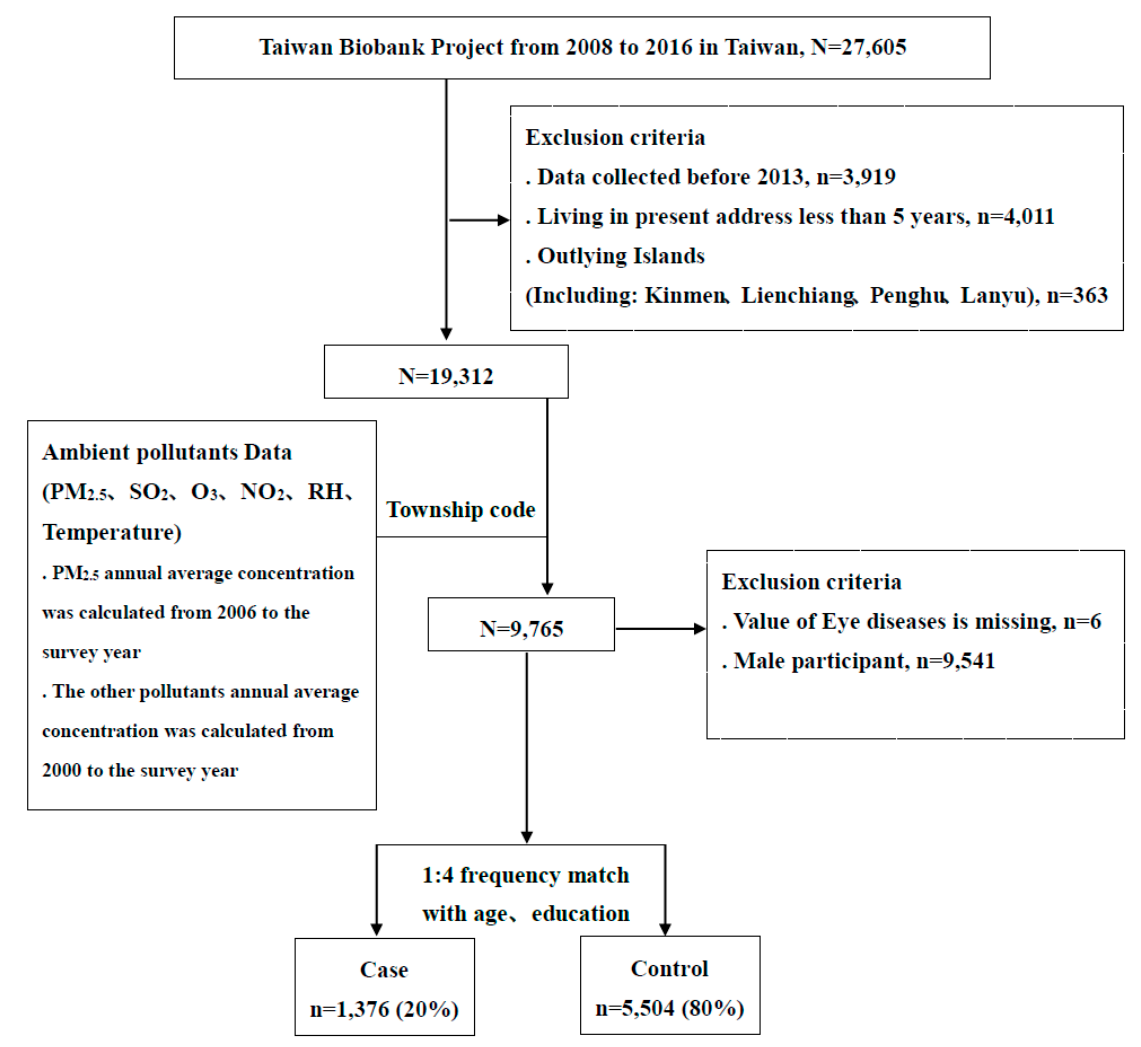
Figure 1. Detailed flow chart of the recruitment procedure in this